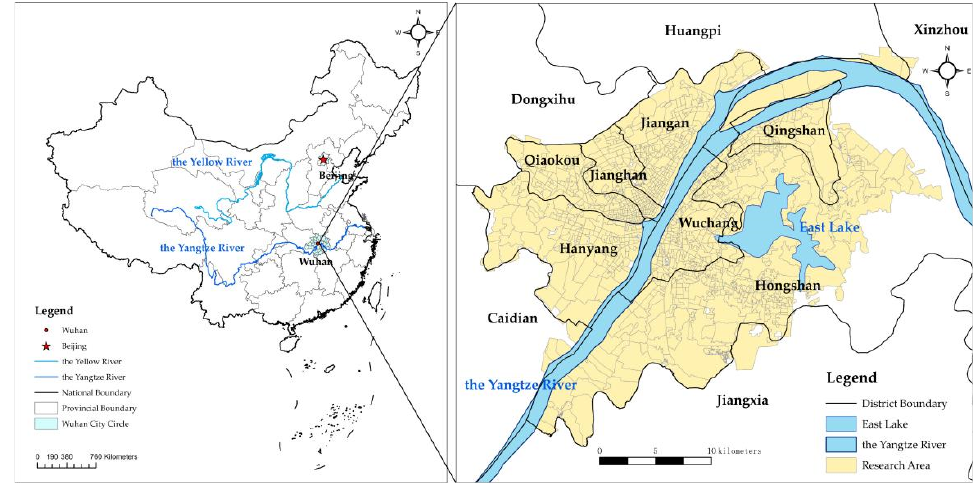
Figure 1. Location of research area